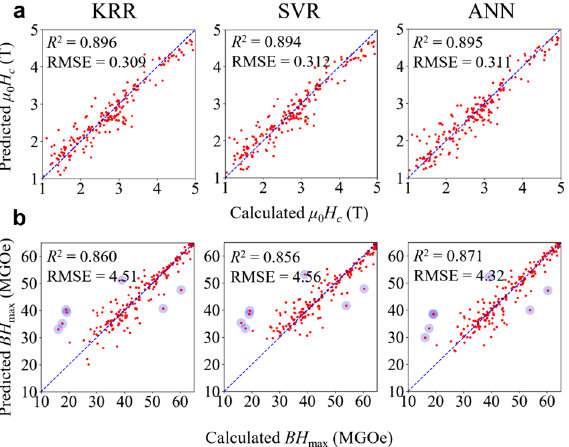
Figure 4. Prediction of final ML models optimized by VFSA with coefficient of determination ( R 2 ) and RMSE indicated as insets. (a) Prediction of coercivity by KRR, SVR, and ANN models. (b) Prediction of BH max by KRR, SVR, and ANN models. The units of RMSE in (a) and (b) are T and MGOe, respectively. The blue translucent dots in (b) indicate the seven outliers with the largest residuals.